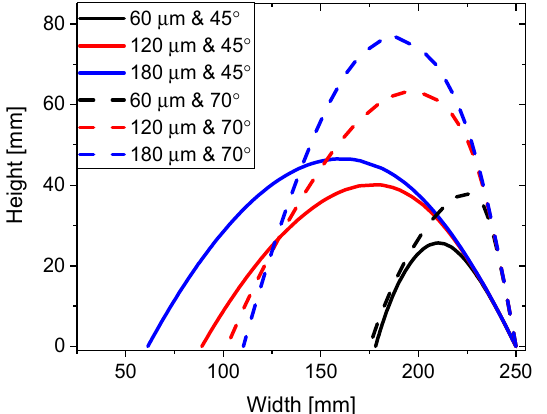
Figure 9. Spatter trajectories for various particle diameters and ejection angles at an ejection speed of 1.5 m/s. Volume flow rate: 250 LPM.